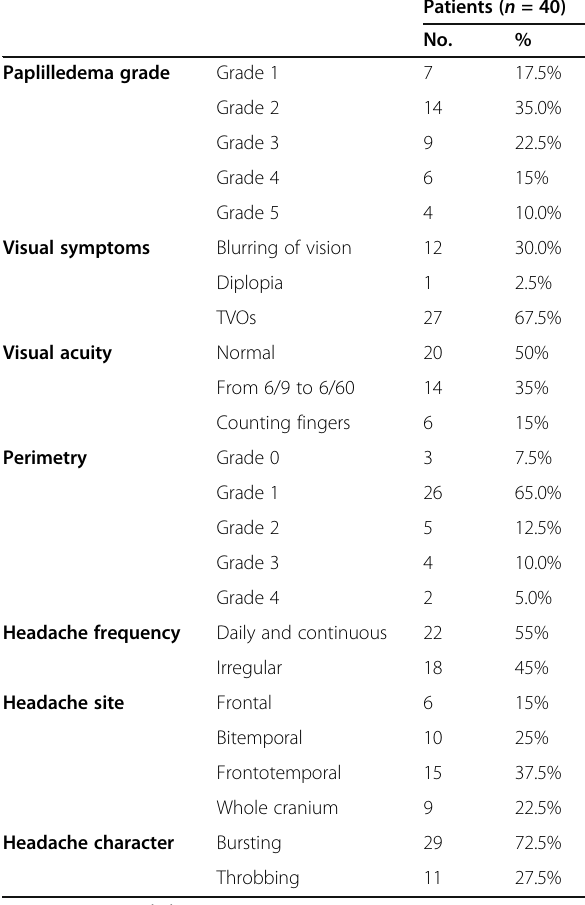
Table 1 The main clinical presentations of the included